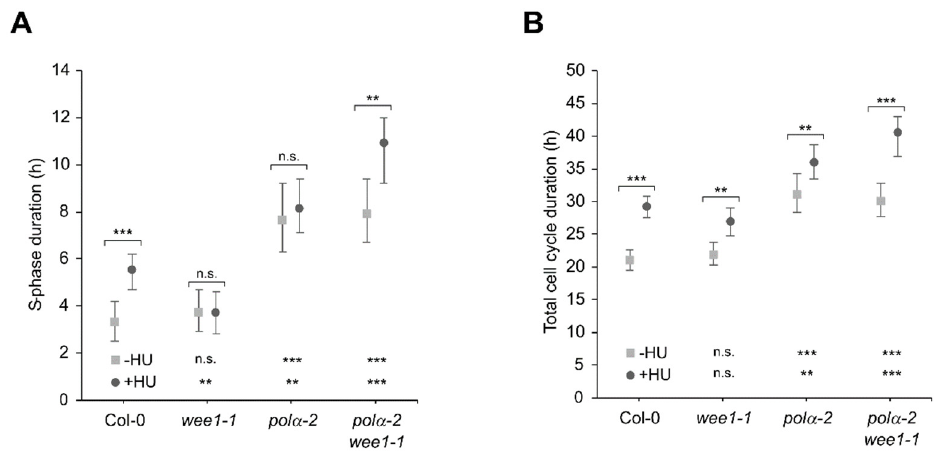
Figure 3. Cell cycle parameters of Col-0, wee1-1 , pol α -2 , and pol α -2 wee1-1 root tip cells under control conditions and treated with HU. ( A , B ) S-phase ( A ) and total cell cycle ( B ) duration were measured using a time course of EdU staining according to the protocol of Hayashi et al. [25]. Data represent the mean ± 95% confidence intervals (n.s., not significant; ** p < 0.01; *** p < 0.001). For S-phase duration, comparisons were tested using ANOVA with Tukey correction. Total cell cycle duration was tested using ANOVA with F-tests to statistically test the equality of the means ( n > 5). As inset, significance is depicted for each treatment of the comparison with Col-0.